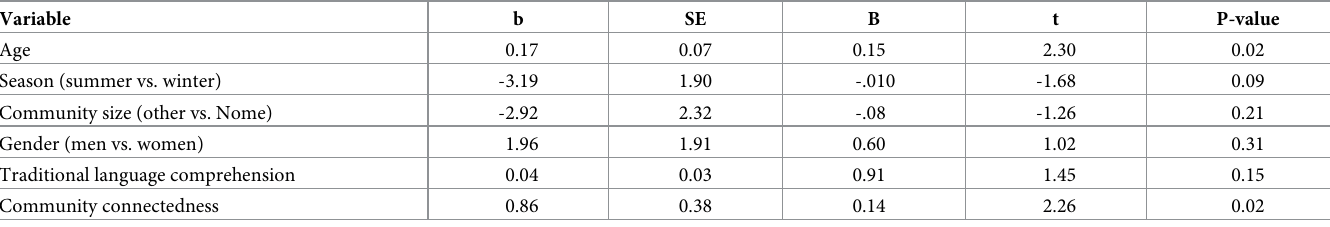
Table 3. Hierarchical multiple regression model predicting the traditional food index with community connectedness. Variable